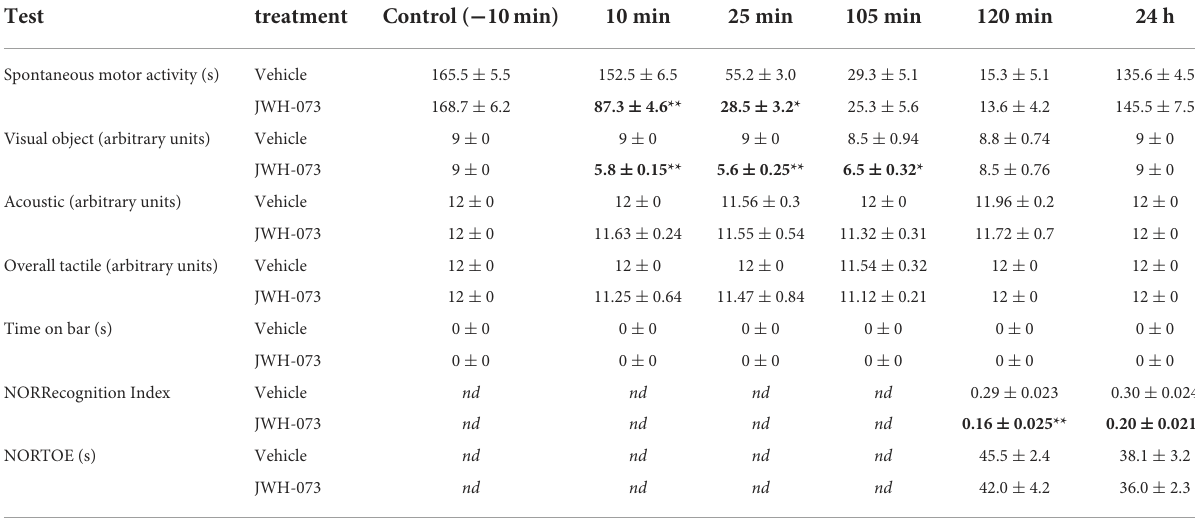
TABLE 1 Effects of JWH-073 (1 mg/kg i.p.) or vehicle on spontaneous motor activity, sensorimotor (visual, acoustic and tactile) responses and object memory recognition (NOR) in